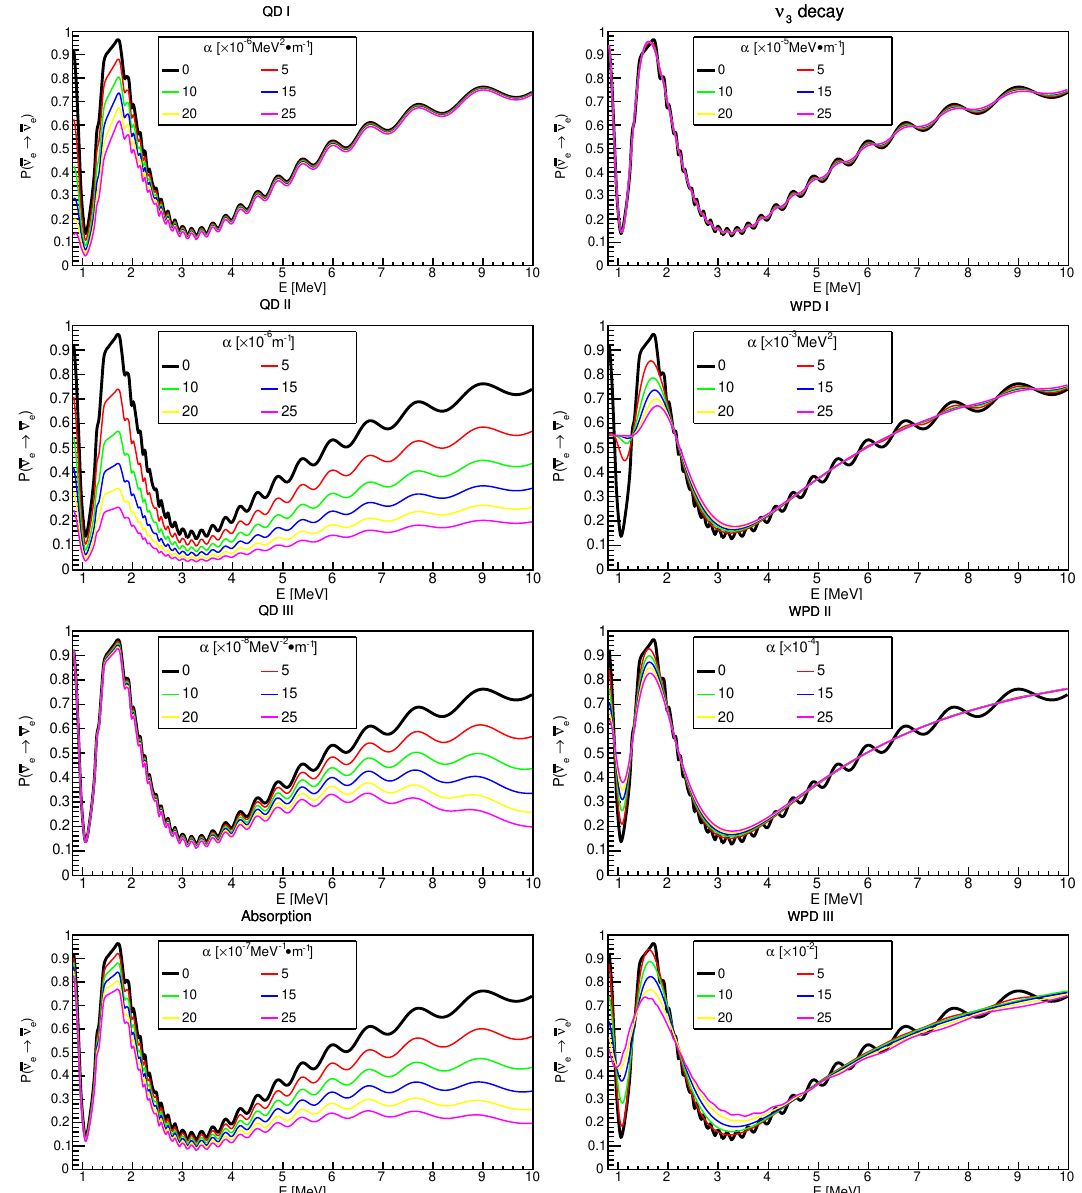
Figure 1. The ¯ ν e survival probability P (¯ ν e → ¯ ν e ) with different damping parameter values for each new physics